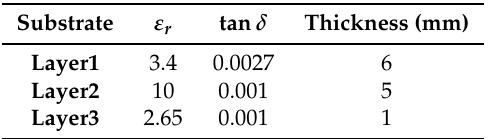
Table 3. The parameters of the substrates used in the array.